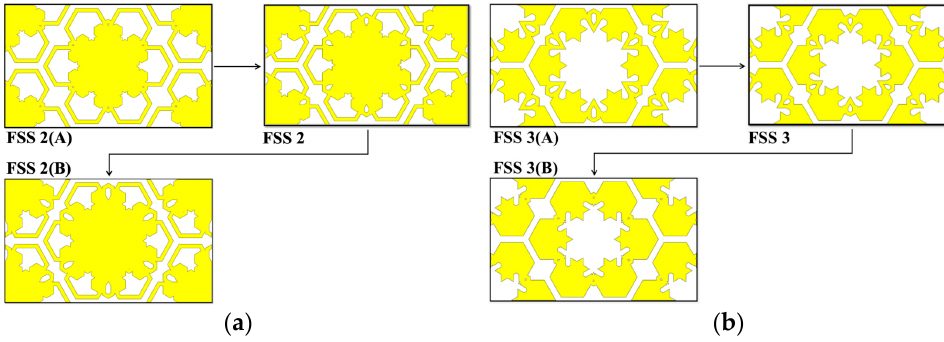
Figure 4. The structural changes of ( a ) FSS 2 and ( b ) FSS 3.